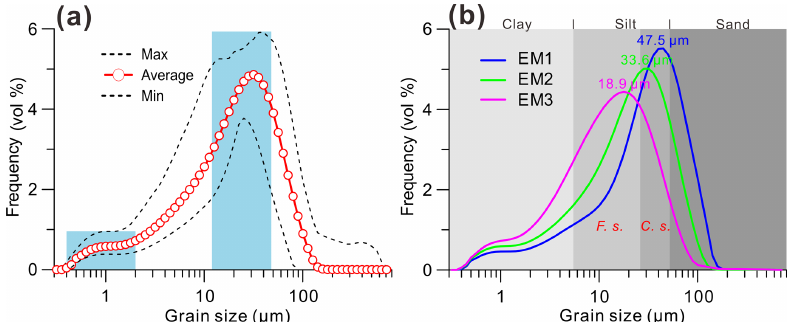
Figure 3. End-member modeling results of the grain size dataset of the NLK section. (a) Mean size distribution and range of volume fre- quency for each size class. (b) Modeled end-members according to the three-end-member model (modal sizes: ∼ 47.5, ∼ 33.6 and ∼ 18.9µm). Size limits of clay, silt and sand fractions determined by laser particle sizer differ from those derived by the pipette method. The upper limits of grain size classes used here are at 4.6 / 5.5µm for clay, 26µm for fine silt, and 52µm for coarse silt, as previously published by Konert and Vandenberghe (1997). Sand is designated for particle sizes > 52µm. Therefore, EM1 and EM2 correspond to coarse silt and EM3 to fine